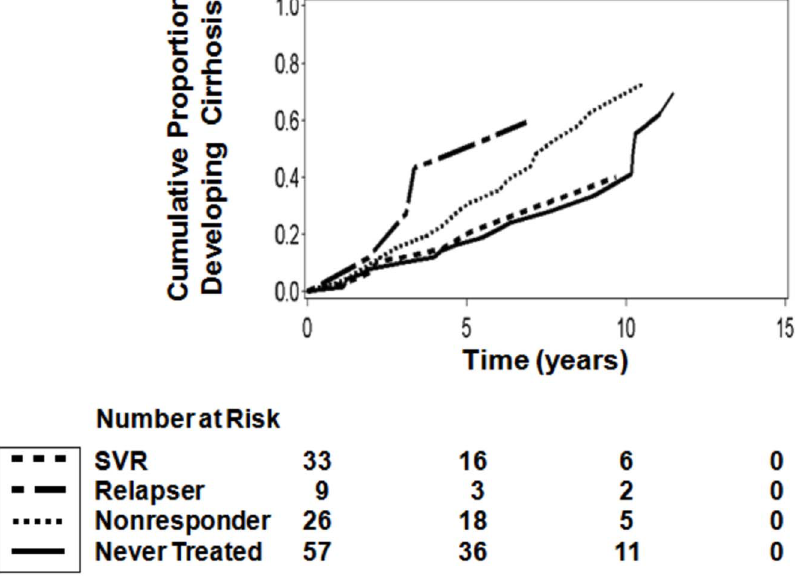
Figure 1. Cumulative incidence of cirrhosis among SFVA patients with baseline fibrosis stages 2 and 3. Age adjusted proportional hazards curves indicate that treatment relapsers and nonresponders had a higher incidence of cirrhosis over the study period compared to never treated patients, but these differences were not statistically significant unadjusted for other risk factors. doi:10.1371/journal.pone.0061568.g001 PLOS ONE |